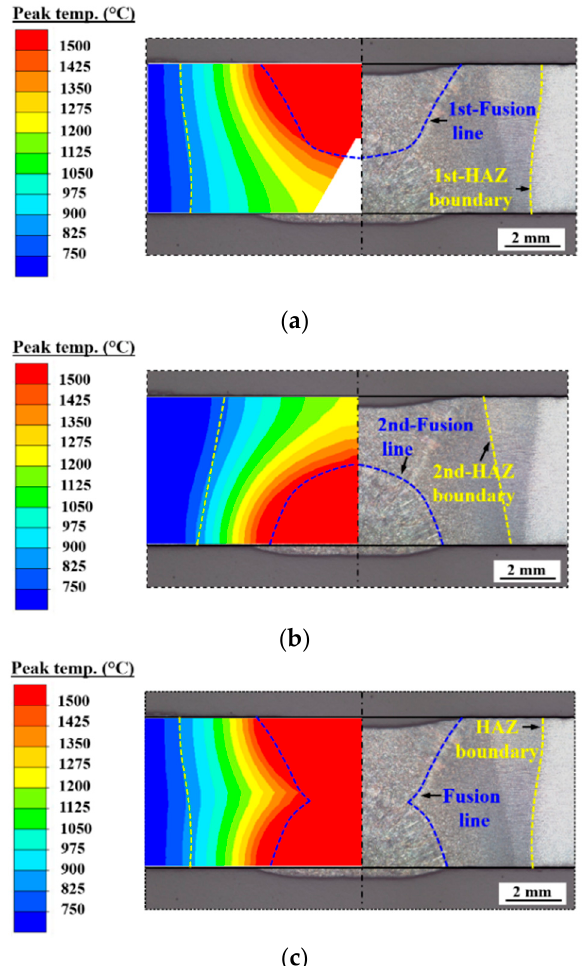
Figure 10. Comparison of the weld between experiment and FEM (case B-1): ( a ) Pass 1; ( b ) pass 2; ( c ) all passes.